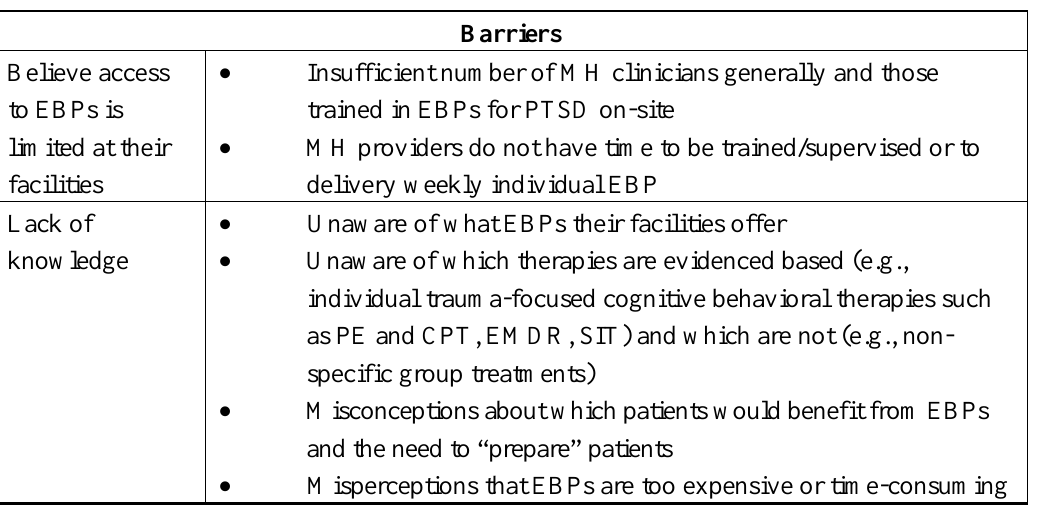
Table 2. Barriers and Facilitators to EBP Adoption from the Perspectives of Prescribing Clinicians. Prescribing clinicians’ response themes related to barriers and facilitators of EBPs for PTSD. The most commonly identified barrier was limited access to EBPs in their facilities. Prescribing clinicians also lacked knowledge in other areas and held some misperceptions that may delay or deter EBPs. Commonly identified facilitators